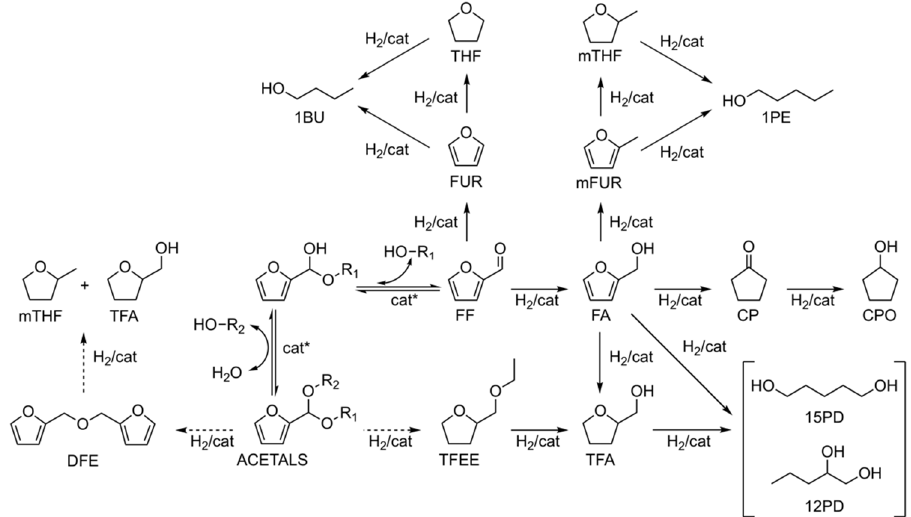
Scheme 1. Reaction pathways involved in the hydrogenolysis of furfural on NiCuAl catalysts (both HO-R 1 and HO-R 2 may be either ethanol or